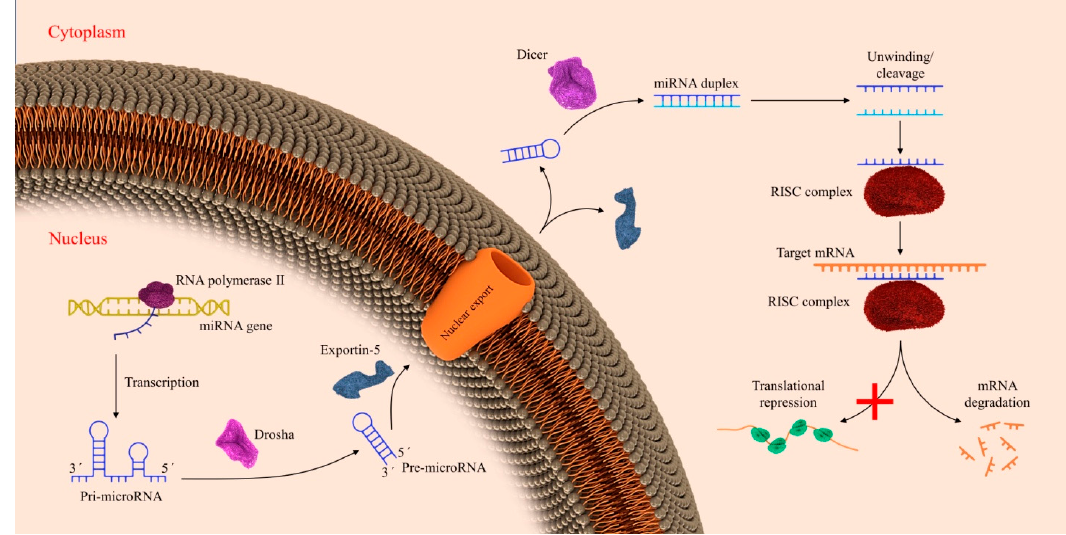
Figure 3. Biosynthesis of miRNAs. A miRNA precursor could be a mature miRNA by various physiological steps (see text for further information).